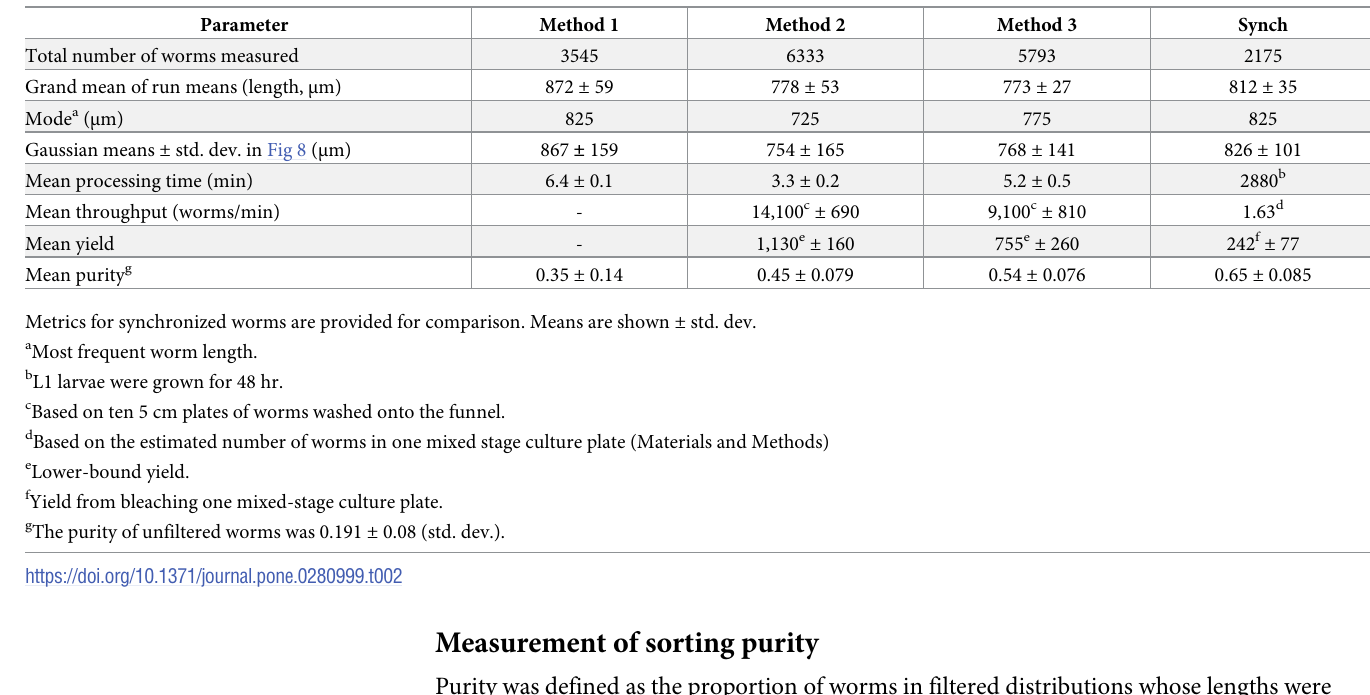
Table 2. Performance metrics of filtration methods for enrichment of particular larval